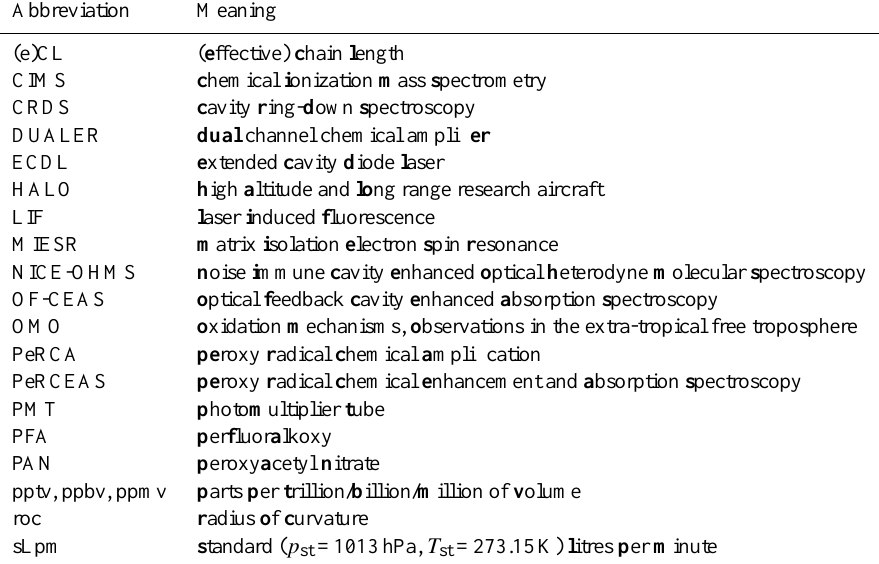
Table A1. Acronyms used in this